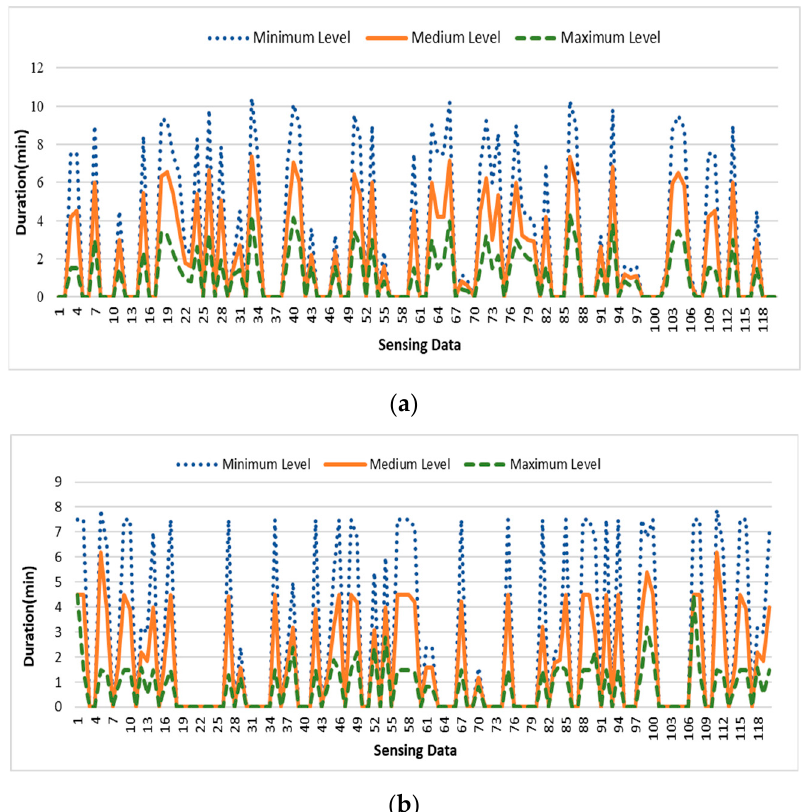
Figure 15. Operational duration results based on different working levels. ( a ) Fogging system. ( b ) Dehumidifier.